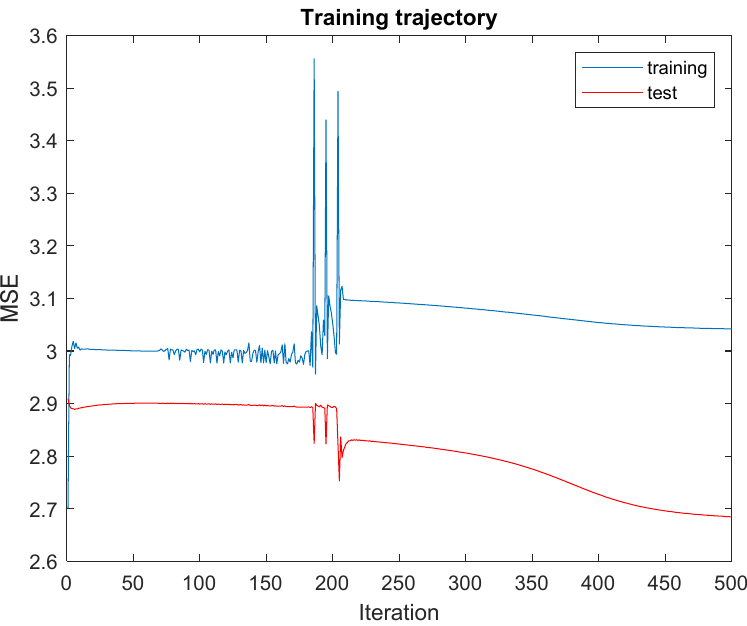
Figure 8. Training trajectory of the neuro-fuzzy classifier trained through gradient descent after the initial genetic search was completed. Table 4. Overall classification rates obtained in this experiment.